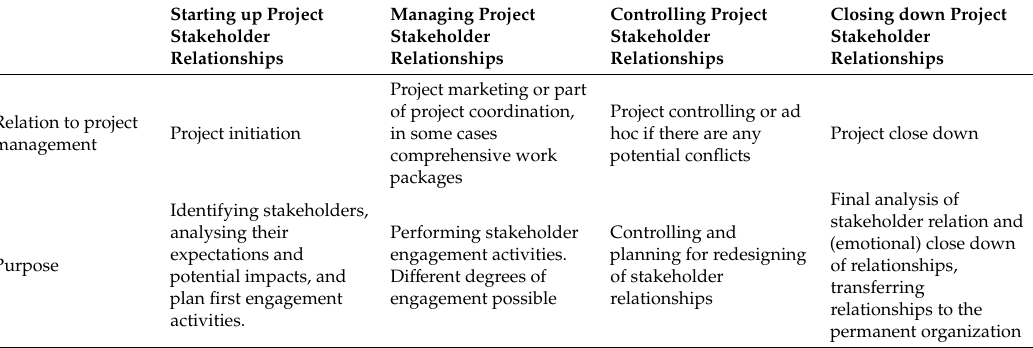
Table 1. The stakeholder management process (Huemann and Zuchi 2014, pp. 394–95, edited).